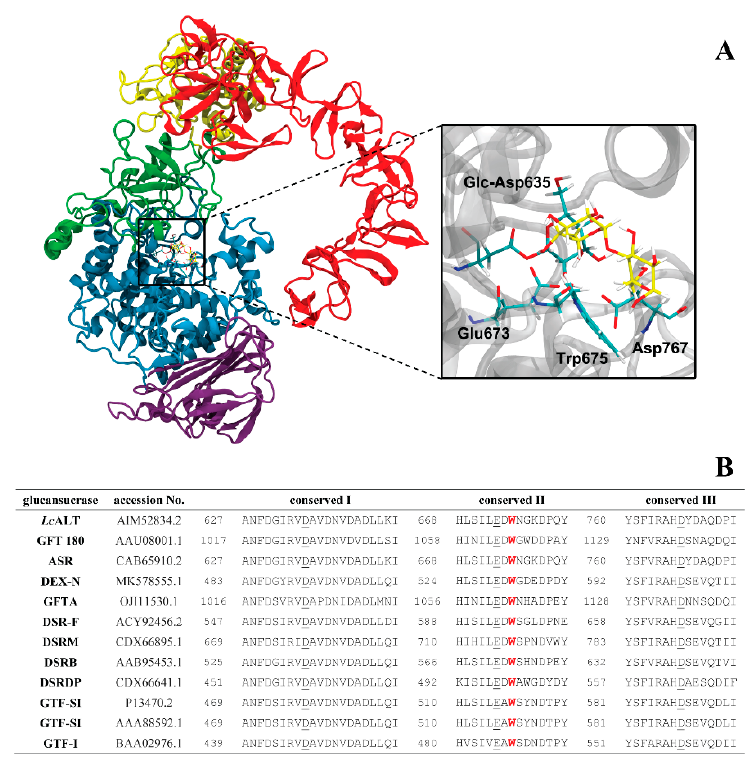
Figure 1. Homology model and conserved sequence of various glucansucrase. ( A ) The catalytically competent binding conformations of maltose in the binding site of Leuconostoc citreum ABK-1 alternansucrase, containing the glucosyl-D635 (glc-D635) intermediate. ( B ) Three conserved sequences of various glucansucrases. The underlined residues are catalytic residues, while the red residue is the conserved +2 tryptophan subsite in Lc ALT and other glucansucrases.